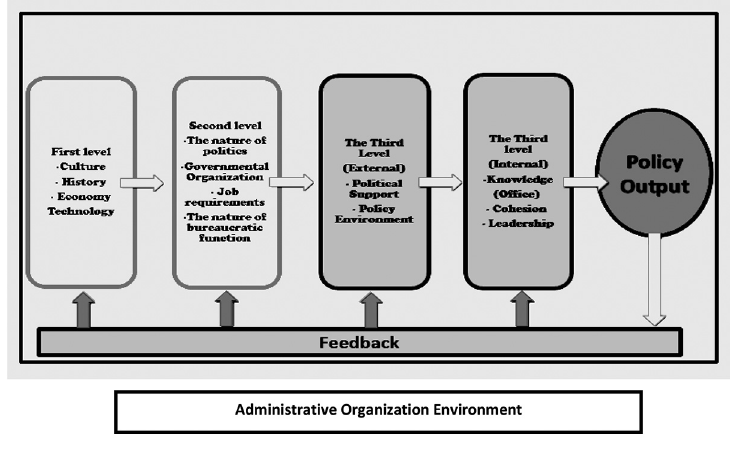
Figure 2. Administrative organization